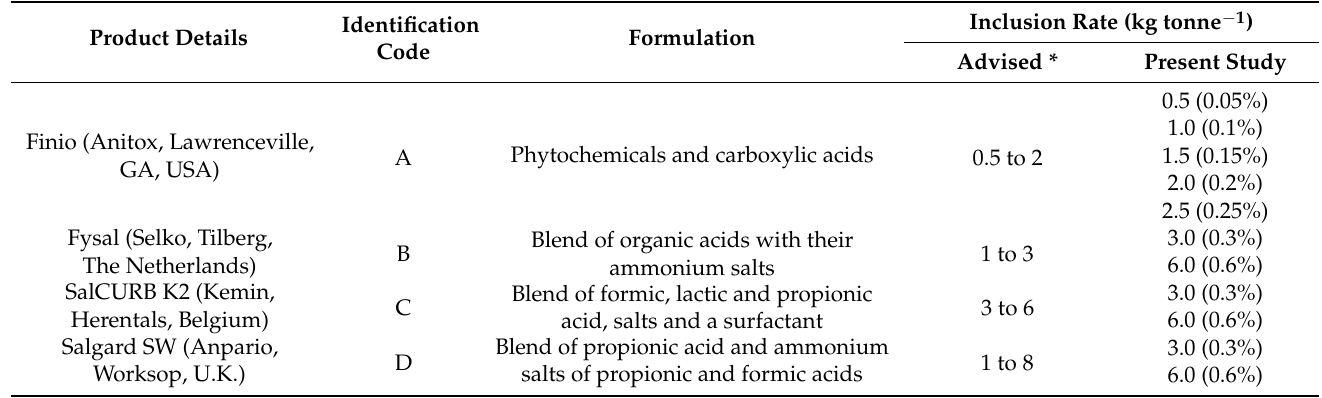
Table 3. Organic acid products and treatment